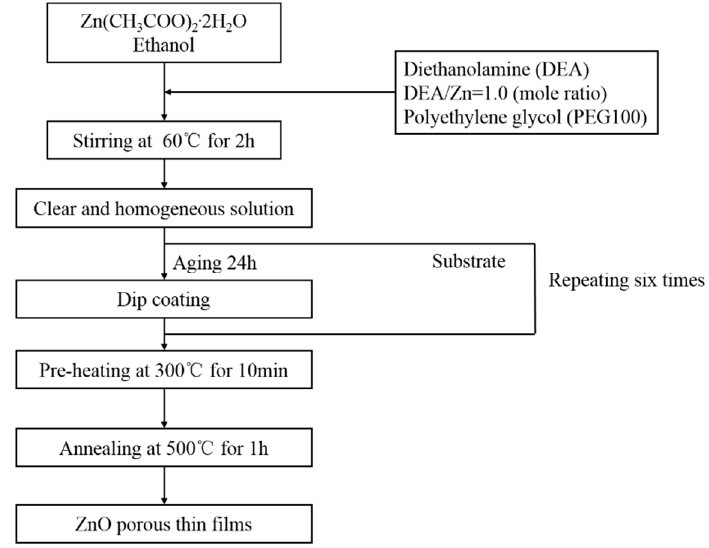
Figure 1. The flow chart showing the procedure for preparing the ZnO porous thin films.